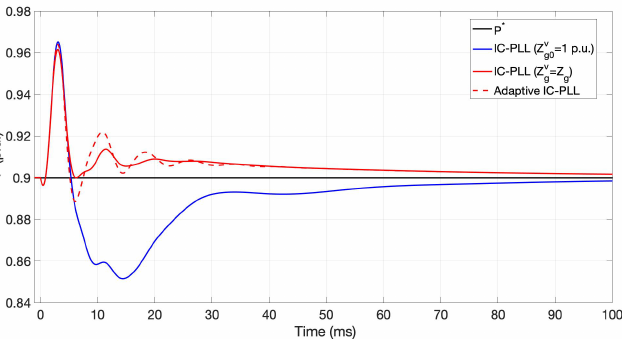
Figure 8. Time-domain response of the active power for different types of PLLs for step change in Z g = 1 1.1 p.u. and for ω FL , PLL = 400 rad/s (inverter →